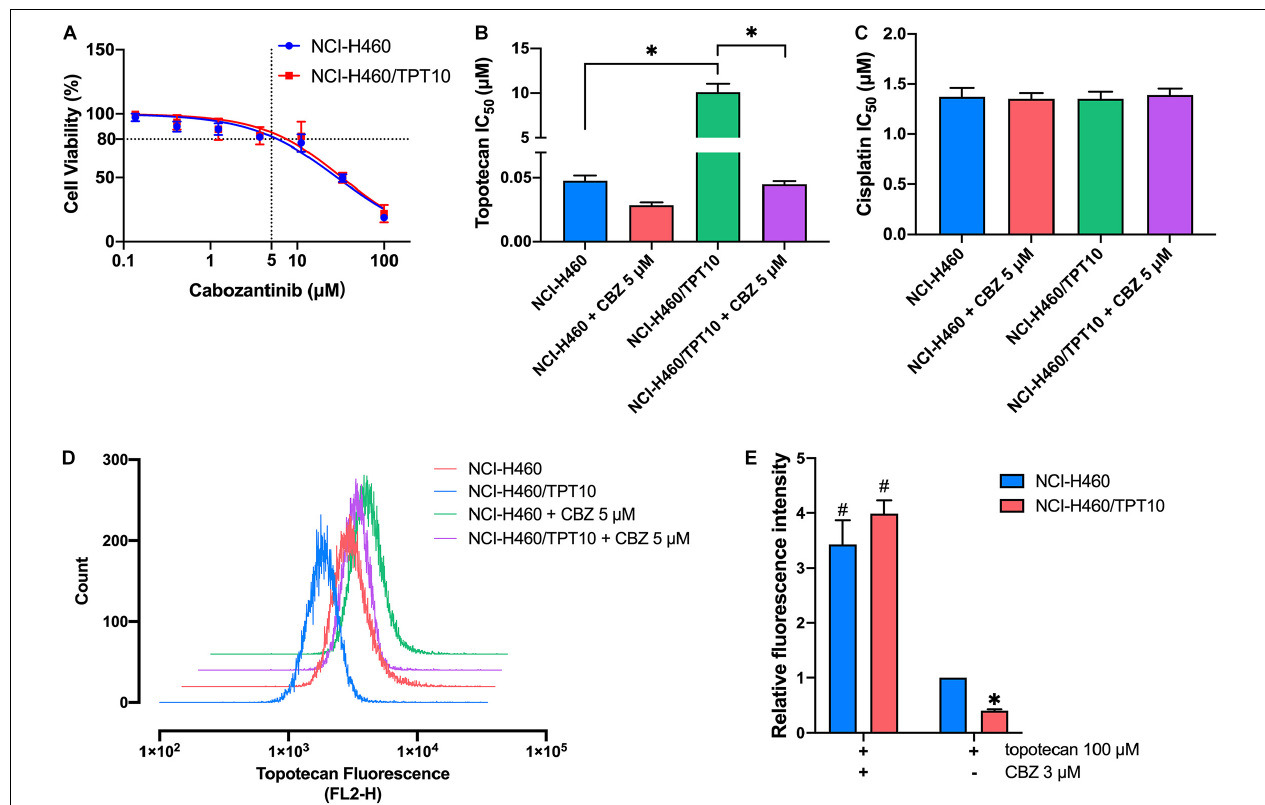
FIGURE 1 | Effect of cabozantinib on reversing topotecan resistance and restoring intracellular topotecan. (A) Cell viability was determined by MTT assay and displayed the changes in response to different concentrations of cabozantinib in topotecan-resistant NCI-H460/TPT10 and the parental NCI-H460 cells. Data points with error bars represented the mean viability (%) ± SD of at least three independent experiments, each done in triplicate. (B,C) Effects of cabozantinib on the IC 50 values of topotecan (B) and cisplatin (C) in NCI-H460/TPT10 and NCI-H460 cells. CBZ is the abbreviation of cabozantinib. Columns and error bars represented mean ± SD of IC 50 values acquired from three independent experiments in triplicate. ∗ p < 0.05. (D) Flow cytometry detection of intracellular accumulation of topotecan in cells after 2 h exposure to 100 µ M topotecan with or without 2 h pretreatment with 5 µ M cabozantinib. (E) Intracellular topotecan accumulations in cells are represented by the fold of fluorescence intensity, which is calculated by (mean FL2-H unit of cells in 100 µ M topotecan with or without cabozantinib – mean FL2-H unit of untreated cells with or without cabozantinib)/(mean FL2-H unit of parental cells in 100 µ M topotecan – mean FL2-H unit of untreated parental cells). Fluorescence intensity of the accumulated topotecan in NCI-H460 cells without cabozantinib was normalized to 1. Columns and error bars represented average values with SD from three independent measurements. ∗ indicates p < 0.05 comparing resistant cell line to parental cell line with the same treatment; # indicates p < 0.05 comparing a group with cabozantinib to the corresponding cell line group without cabozantinib.